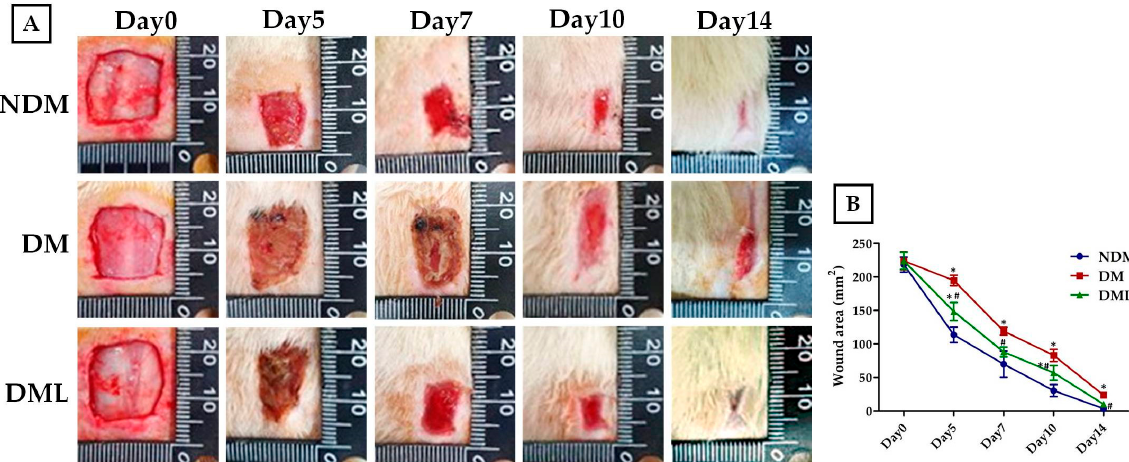
Figure 2. Effects of luteolin on wound healing rate in STZ-induced diabetic rats. Skin wound was generated with 15 mm punch biopsies on the dorsal thorax of STZ-induced diabetic rats and non-diabetic rats. ( A ) Representative images of the skin wound were recorded on days 0, 5, 7, 10, and 14 during the experimental period. ( B ) Quantitative images of the wound margin were obtained by measuring the pixel size. Values of individual groups are presented as mean ± SEM. * p < 0.05, compared with NDM group. # p < 0.05, compared with DM